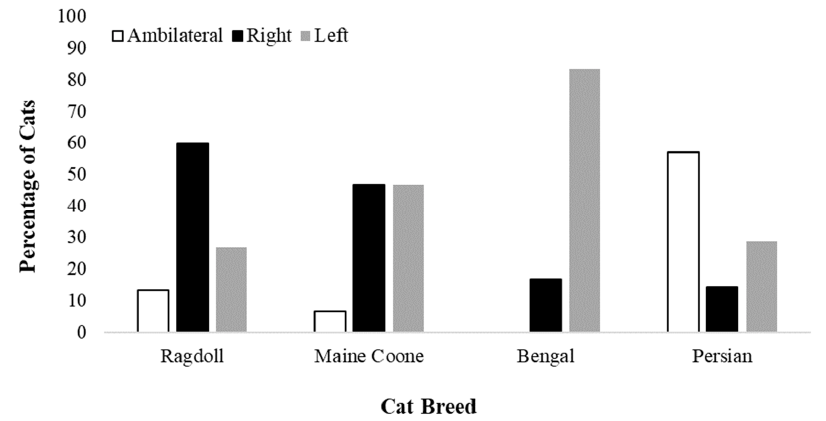
Figure 2. Distribution of paw preferences according to cat breed.